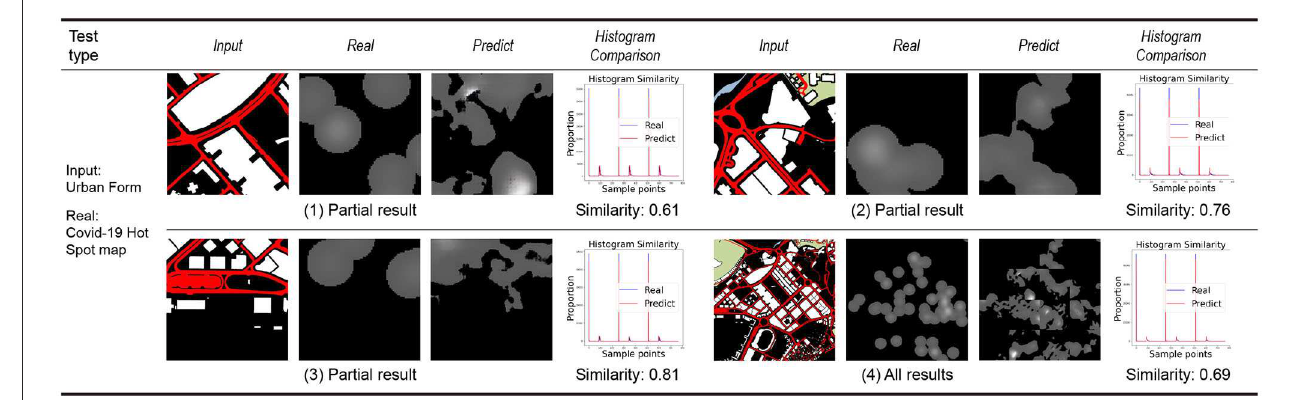
FIGURE8 Taipa urban morphology prediction results.